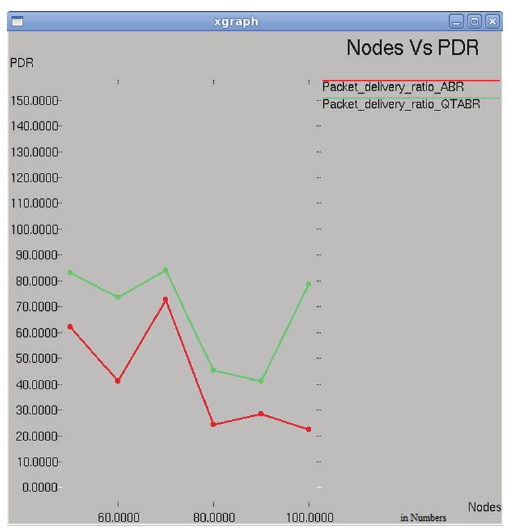
Figure 6: Packet size versus PDR.